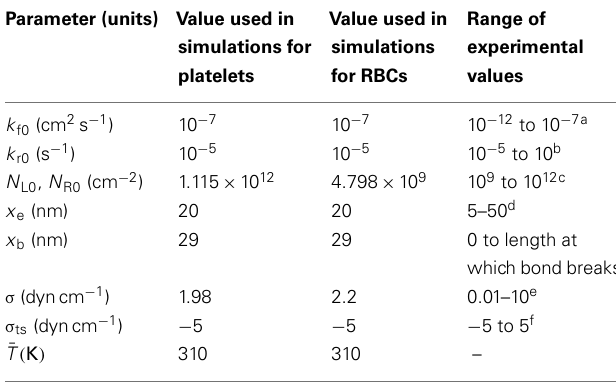
Table 3 |Values of parameters related to receptor-ligand binding used in simulations and ranges of experimental values